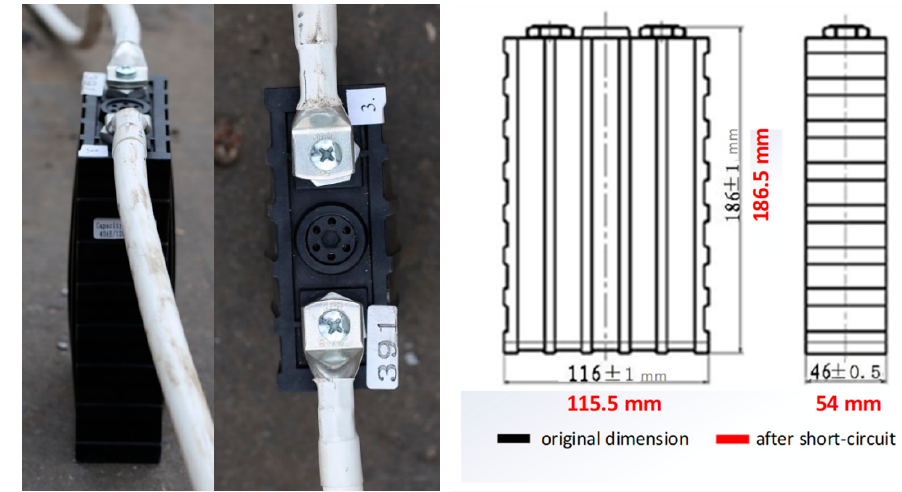
Figure 6. Geometrical changes of the cell package after short-circuit test.